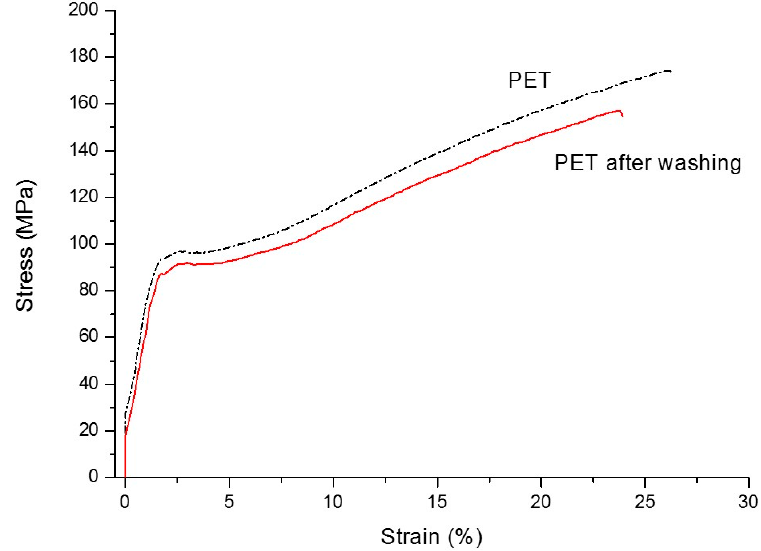
Figure 8. Representative stress/strain curves of PET films before ( left ) and after ( right ) coating with whey and whey removal by washing with Alcalase at 50 °C for 2 h. Table 8. Stress at yield, tensile strength, and elongation at break of PET film and the same film after